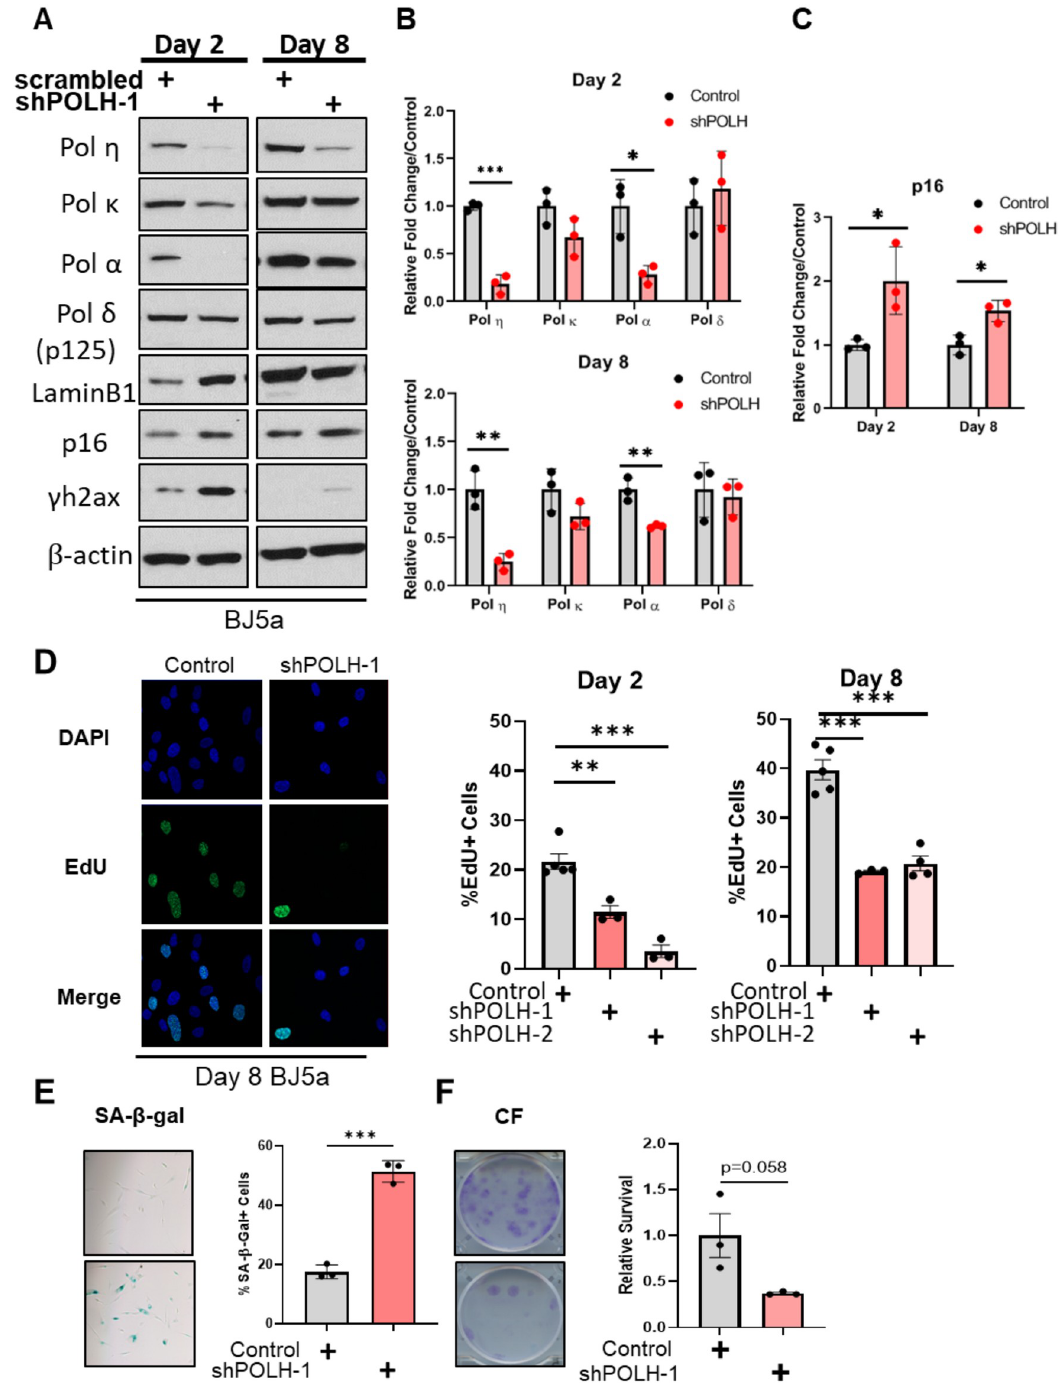
Fig 5. DNA polymerase η depletion is sufficient to induce a senescence-like growth arrest. (A). hTERT -BJ5a cells were infected with lentivirus expressing shRNA targeting POLH . Scrambled shRNA was used as control. Immunoblot analyses of indicated proteins at days 2 and 8 after lentivirus infection is representative of three biological replicates. (B). Quantification of immunoblot analyses of BJ5a cells infected with POLH or scrambled shRNA lentivirus at days 2 and 8. Data represent mean +/- SD of three biological replicates. (C). Quantification of p16 expression in BJ5a cells infected with POLH or scrambled shRNA lentivirus at days 2 and 8. Data represent mean +/- SD of three biological replicates. (D). Quantification of EdU positive cells (by immunofluorescence) of either two separate shRNA clones or scrambled shRNA at indicated days. Data represent mean +/- SEM for at least three biological replicates with two technical replicates. (E). Quantification of SA- β -gal activity at Day 8. Data represent mean +/- SEM for